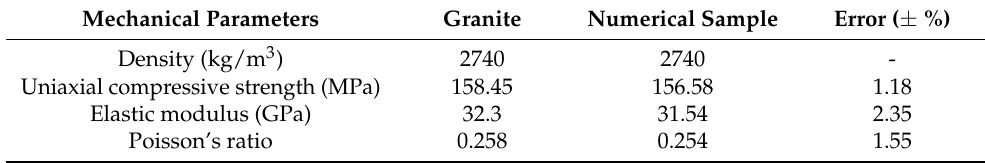
Table 1. Macro mechanical properties of materials.